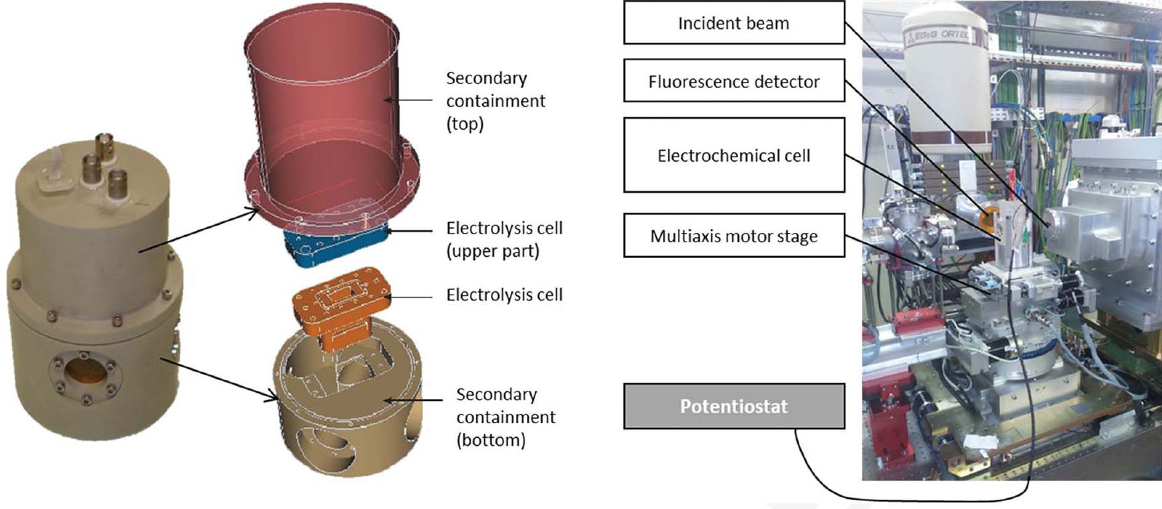
Figure 1 (Left) Double confinement electrochemical–XAS setup, 0.7 < V sol < 2 ml (a magnetic stirrer is placed at the bottom of the setup). (Right) The electrolysis cell at the MARS beamline CX3